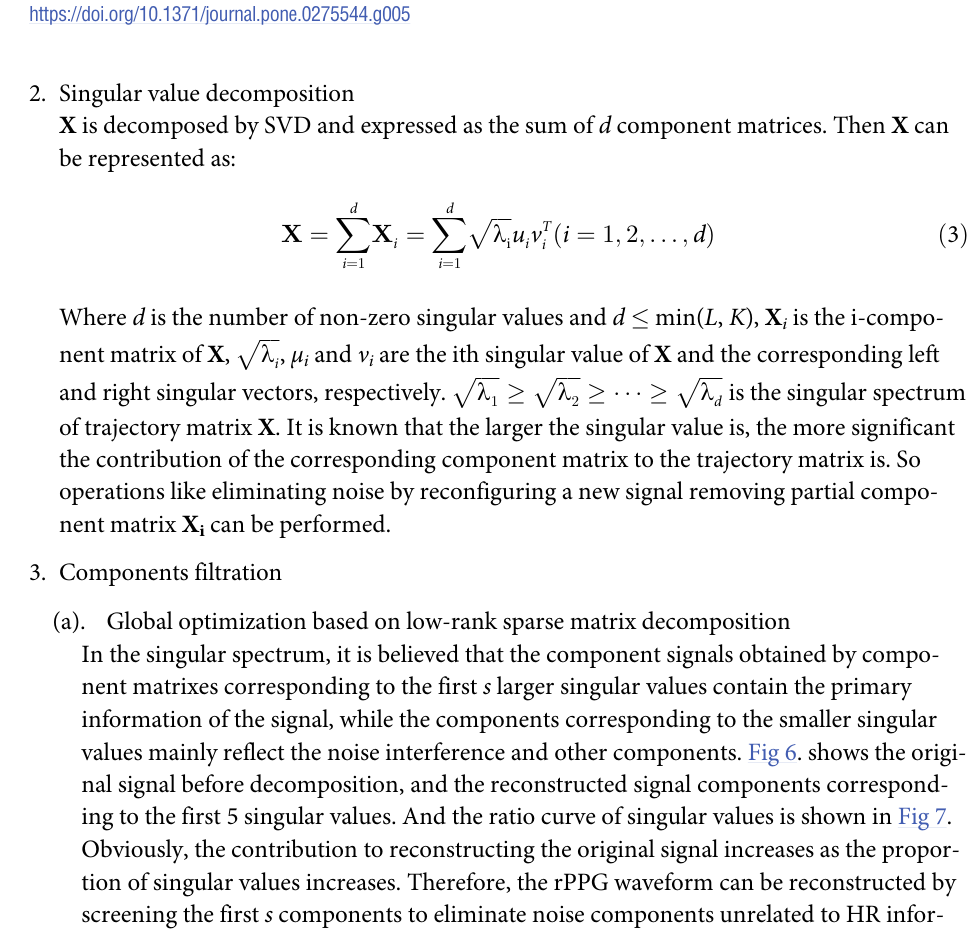
Fig 5. The waveforms of Green channel and after